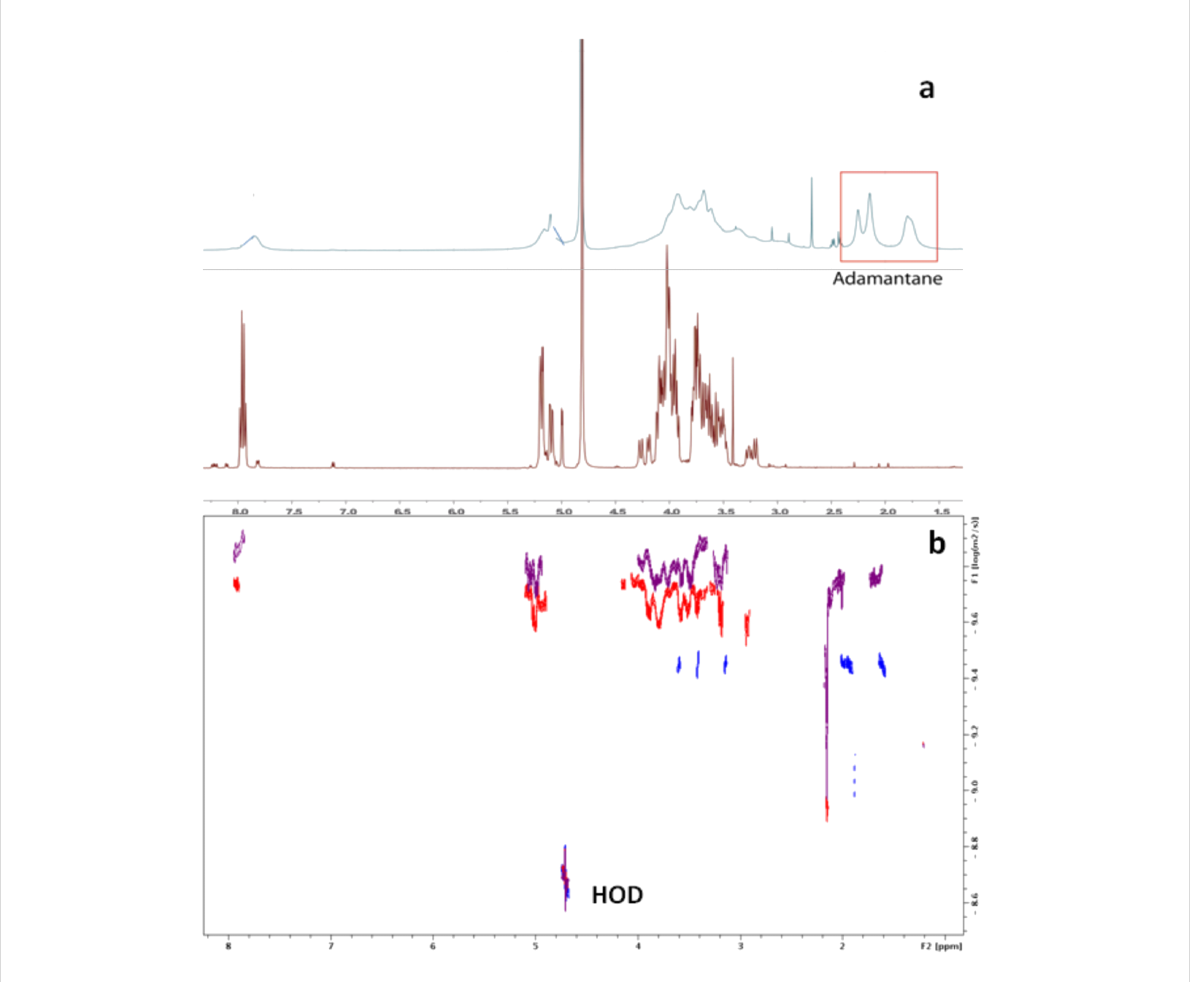
Figure 7: (a) 1 H NMR spectra of AZO-CDim 1 (500 MHz, D 2 O, 2.5 mM) in the absence (bottom) and presence of ADAdim 4 (2.5 mM, top); (b) DOSY spectra of AZO-CDim 1 (red), ADAdim 4 (blue) and an equimolecular mixture of both (purple), (1 mM, D 2